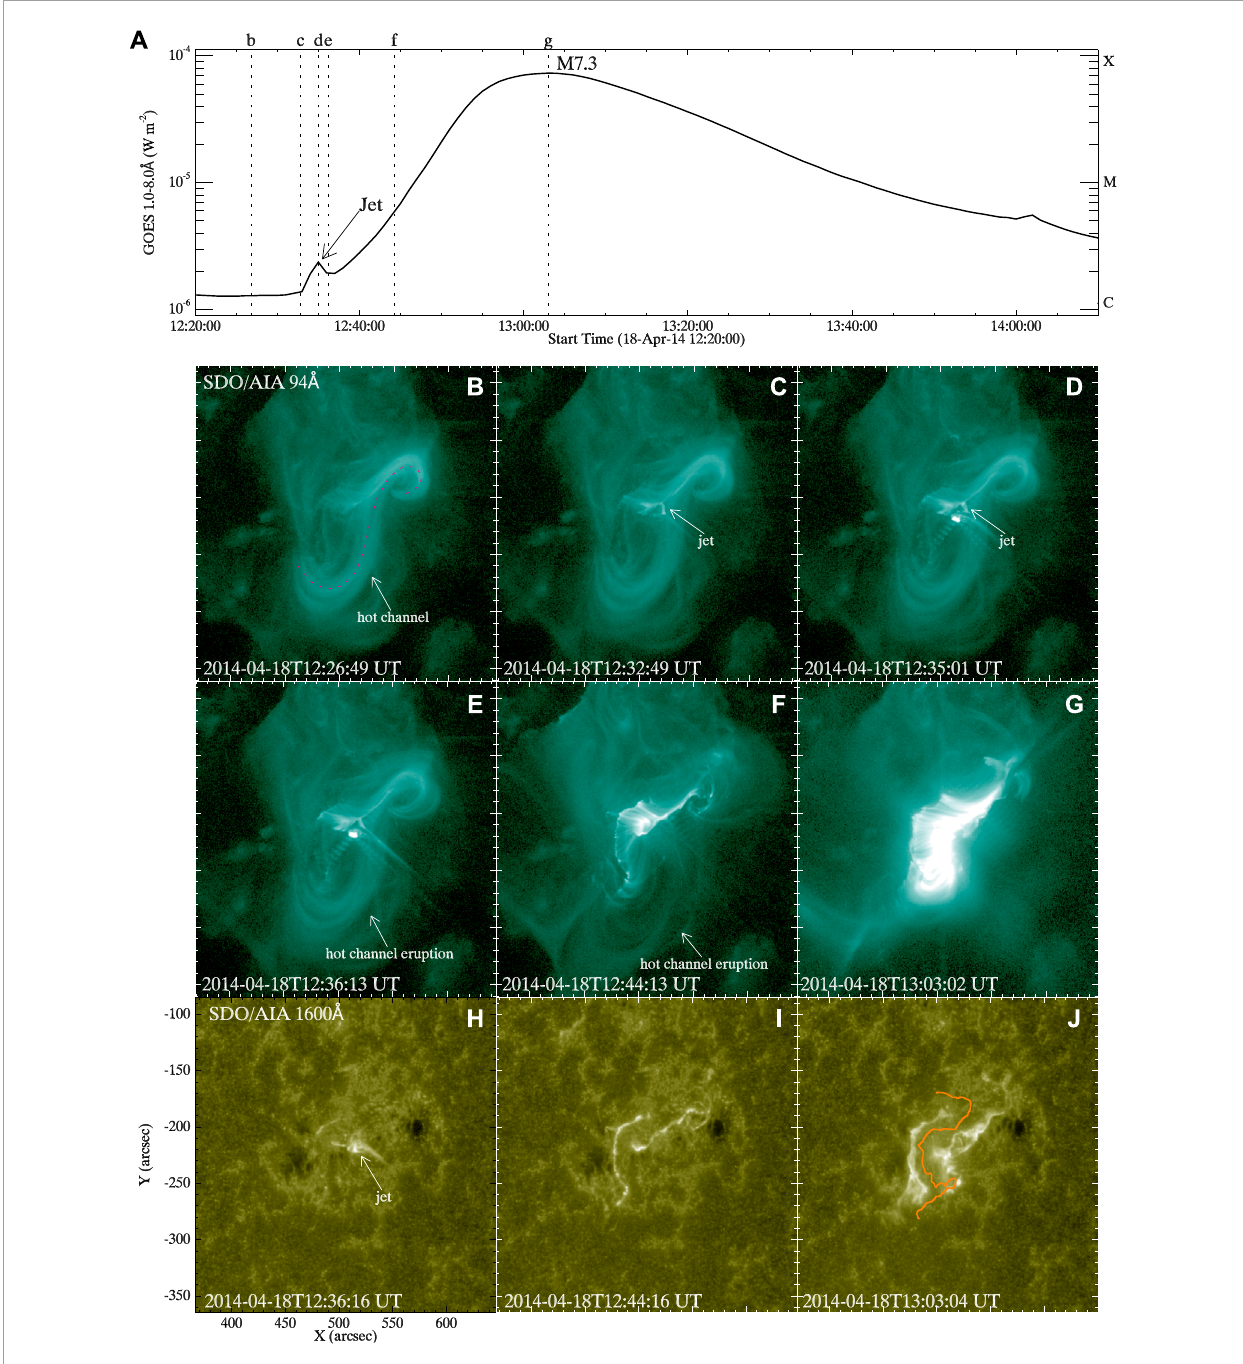
FIGURE 7 Eruption details of the M7.3-class flare. (A) Light curve of the GOES 1-8 Å flux during the flare. (B–G) Snapshots of SDO/AIA 94-Å images during the flare. (H–J) Snapshots of SDO/AIA 1600-Å images during the flare. The orange curve outlines the source PIL of the eruption. An associated animation ( Supplementary Video S4 ) is available